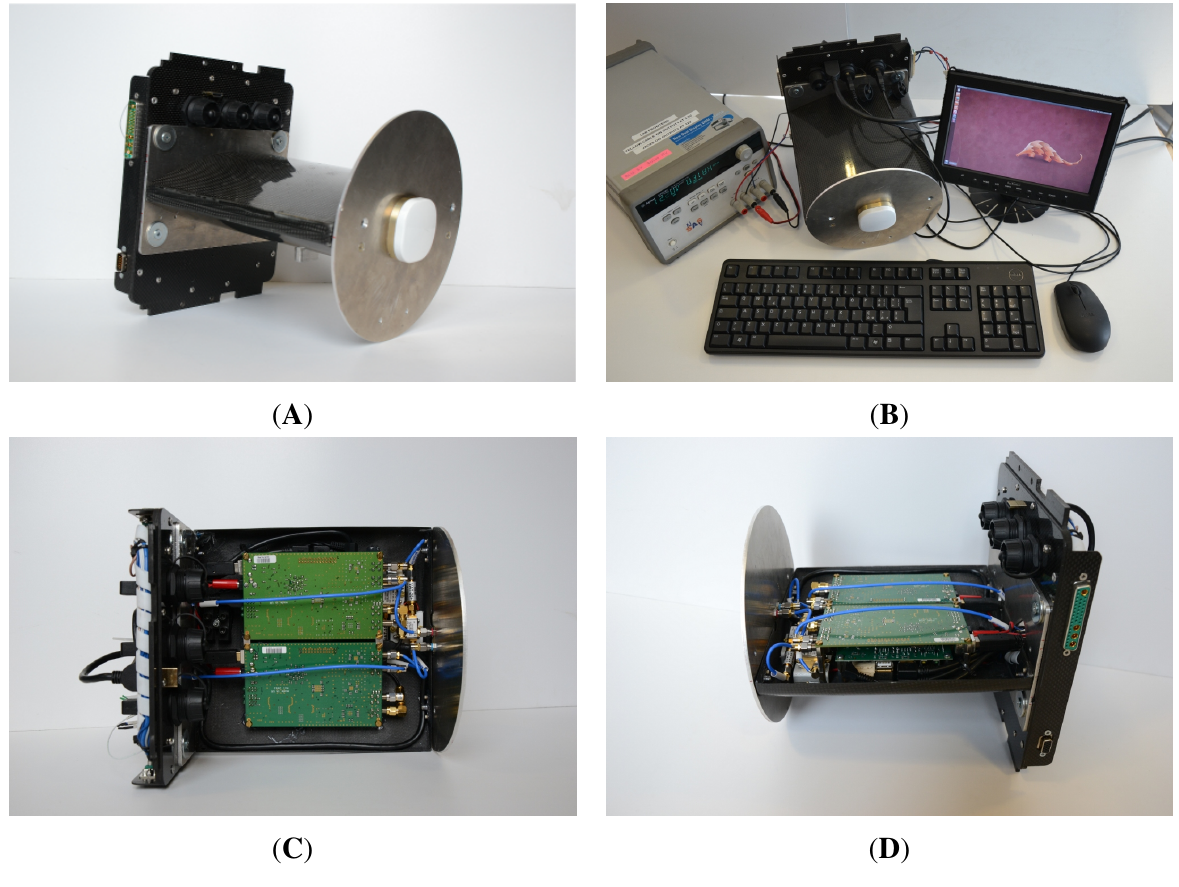
Figure 4. Photos of the sensor prototype, closed in its carbon fiber case ( A ), opened ( C , D ) showing internal components and equipped with a keyboard, mouse, HDMI monitor and power supply for the in laboratory tests ( B